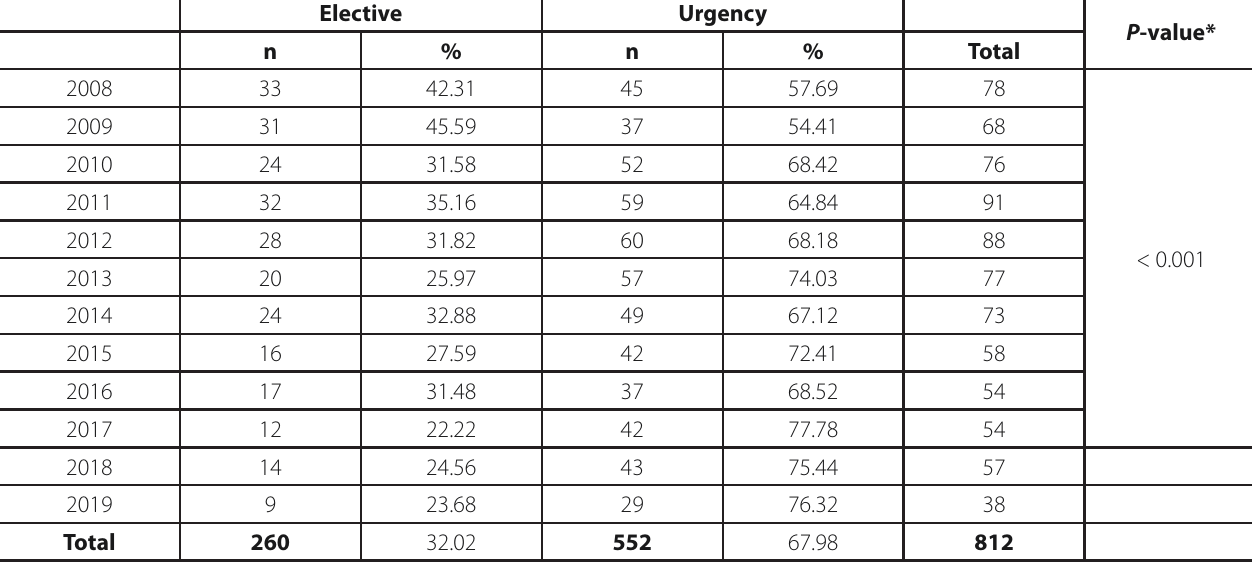
*Trend Chi-squared test Table 2. Absolute and relative mortality per geographic region by procedure type. Geographic region